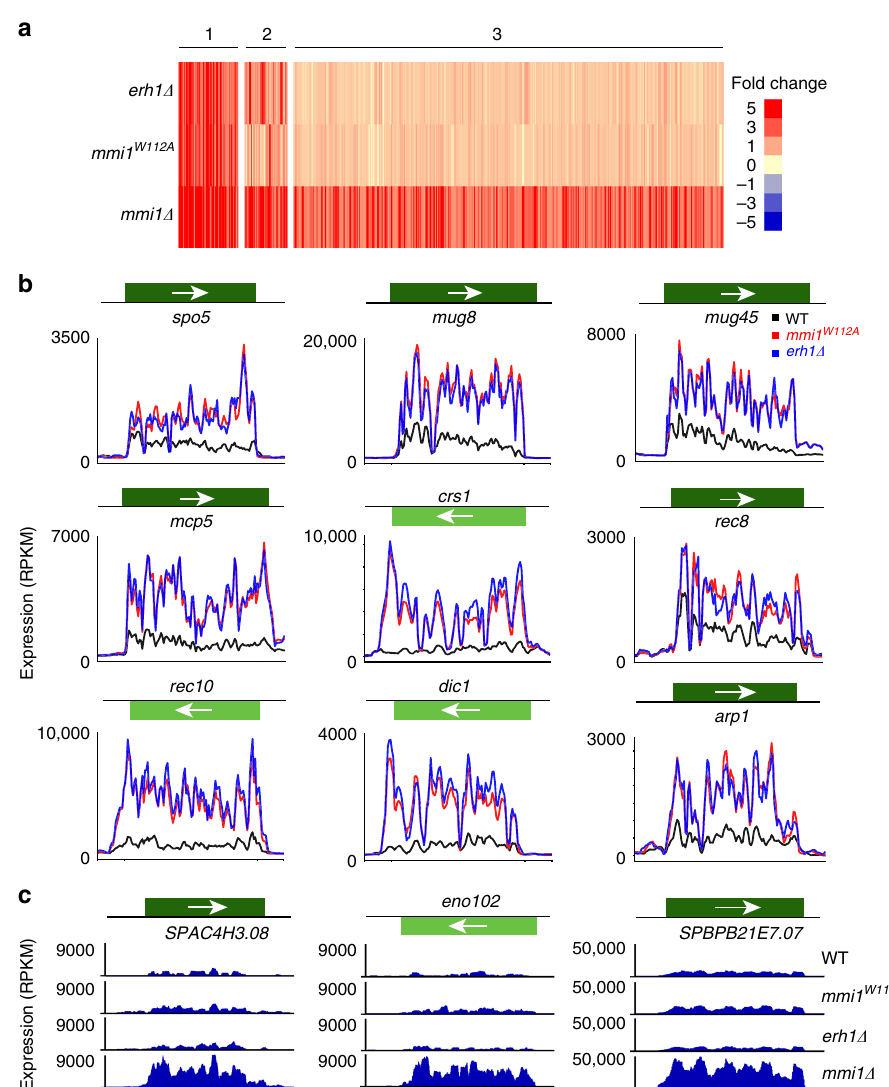
Fig. 6 Mmi1 W112A affects a subset of the Mmi1 regulon silenced by EMC. a Heatmap of genes upregulated by ≥ 2-fold in at least one mutant as compared to WT. Cluster 1 contains genes that are derepressed in mmi1 Δ , mmi1 W112A , and erh1 Δ . Cluster 2 contains genes that are derepressed in mmi1 Δ and mmi1 W112A or erh1 Δ . Cluster 3 contains genes that are derepressed in mmi1 Δ only. In total, there are 531 genes considered here as upregulated out of a possible 7019. Source data are provided as a Source Data fi le. b RNA-seq pro fi les of 9 representative genes whose repression requires Erh1-Mmi1 interaction. The color scheme used is WT (black), mmi1 W112A (red), and erh1 Δ (blue). Shown is normalized RPKM expression. c RNA-seq pro fi les of 3 representative loci showing derepression in mmi1 Δ but not in mmi1 W112A and erh1 Δ